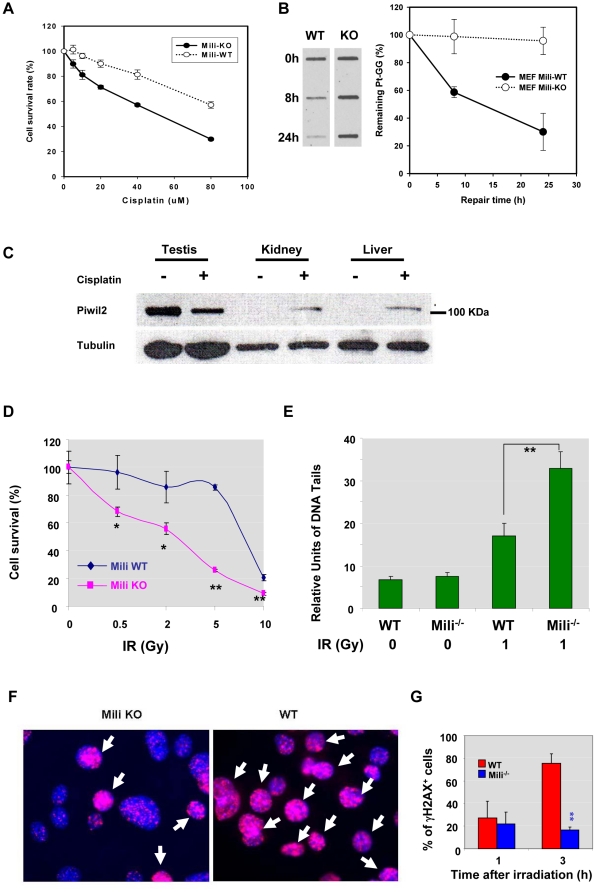
Piwil2 is required for repair of DNA damage induced by IR and cisplatin.
A, B & C. Piwil2 is required for repair of DNA damage induced by cisplatin. (A) The survival rate of mili-/- MEFs was significantly reduced in a dose-dependent manner as compared to WT MEFs after cisplatin treatment in various doses. The relative cell survival rate was determined by methylene blue staining (n = 3). **, p<0.01. (B) DNA repair in the cisplatin-treated mili-/- and WT MEFs. The MEFs were treated with cisplatin for 1 h, cultured and harvested at the indicated time for ISB assay to determine amounts of Pt-GG in the cells (n = 3). (C) Cisplatin induced Piwil2 expression in vivo. Male mice were treated i.p. with cisplatin (20 mg/m2) or vehicle (PBS) for 5 consecutive days and kidney, liver and testis were harvested and whole cell lysates from the tissue were prepared and subjected to Western blotting with monoclonal anti-piwil2 IgM antibody (Kao2 supernatant; 1∶50). The data shown were a representative of two experiments. D & E. Piwil2 is required for repair of DNA damage induced by IR. (E) Mili-/- and WT MEFs were seeded at 1×105/well in 6-well plates in triplicates. When cells grew to 50–60% confluence (2 days) they were exposed to various doses (0, 0.5, 2, 5, 10 Gy) of X-ray (RS 2000 Biological Irradiator; Rad Source Technologies, Inc. Alpharetta, GA). Four days after irradiation, cells were harvested and counted with trypan blue exclusion of dead cells. Cell survival rate was calculated as percentage of viable cells of each dose normalized to untreated counterparts (n = 3). *, p<0.05; **, p<0.01. (E) DNA repair in IR-treated MEFs. Mili-/- and WT MEFs were X-rayed at exponential growth phase and comet assay was performed with standard protocol. DNA damage was estimated by measuring the distance of the tail against the edge of far side of the nuclei for 50 random selected cells (n = 50; **, p<0.001). The data shown are representative of two experiments. F & G. Different size of γH2AX foci in Mili-/- MEFs versus WT MEFs irradiated by X-ray. (F) Representative micrographs of γH2AX foci in MEFs at 3 h after X-ray irradiation (3 Gy). Arrows indicate the MEFs with large γH2AX foci; (G) Quantitation of γH2AX foci in MEFs at 1 and 3 h after X-ray irradiation (n = 3). **, p<0.01 compared between Mili-/- and WT MEFs. Note that there is no significant difference between Mili-/- and WT MEFs in the formation of large γH2AX foci at 1 h after irradiation.